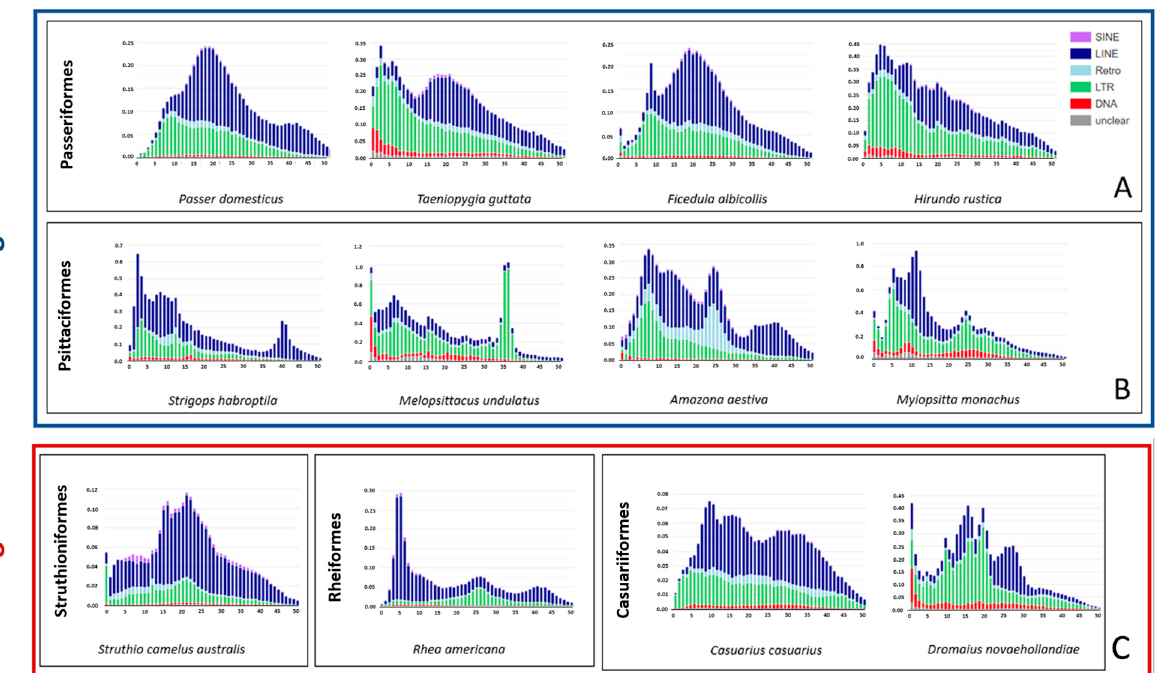
Figure 4. Venn diagrams obtained by the variation partitioning analysis (VPA) using redundancy analysis (RDA). The partition of the variation of a response variable (X) between two sets of explanatory variables (X1 and X2) is shown. Each circle represents the portion of variation accounting for each explanatory variable or a combination of the explanatory matrices. The intersection between the two circles represents the amount of variation explained by both variables X1 and X2. The response variable (X) is the difference between the LTR retroelements relative abundances; the explanatory variable X1 represents species that have an ancestor that probably experienced an LTR expansion as consequence of climate changes that occurred in Australia and Antarctica during the Eocene-Oligocene transition; the explanatory variable X2 indicates the sequence divergence obtained by p-distance matrix using 16S rDNA sequences.